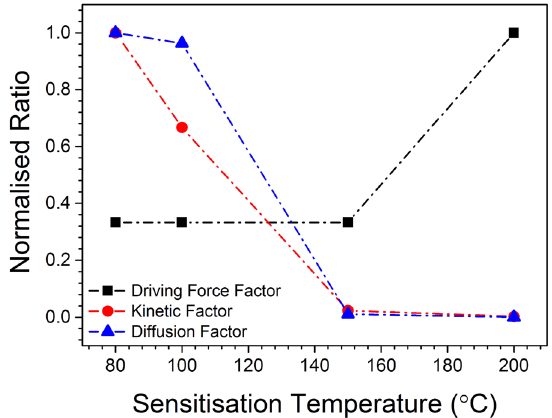
Figure 7. Empirical factors imposed on the CALPHAD model to provide a fit to normalised driving force factor, kinetic factor and diffusion factor applied to modify the CALPHAD model to faithfully represent the experimental data and subsequently provide an analytical model to represent the specific case of grain boundary